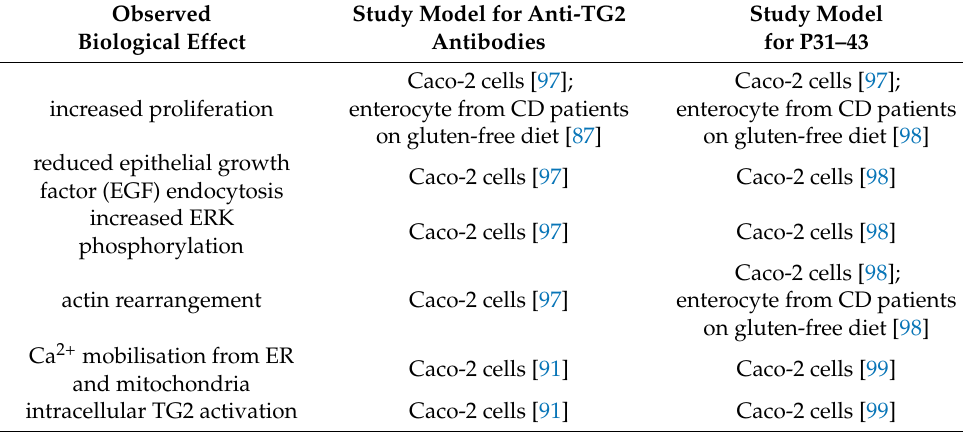
Table 2. Biological effects evoked by both anti-TG2 antibodies and P31–43 in human in vitro models.